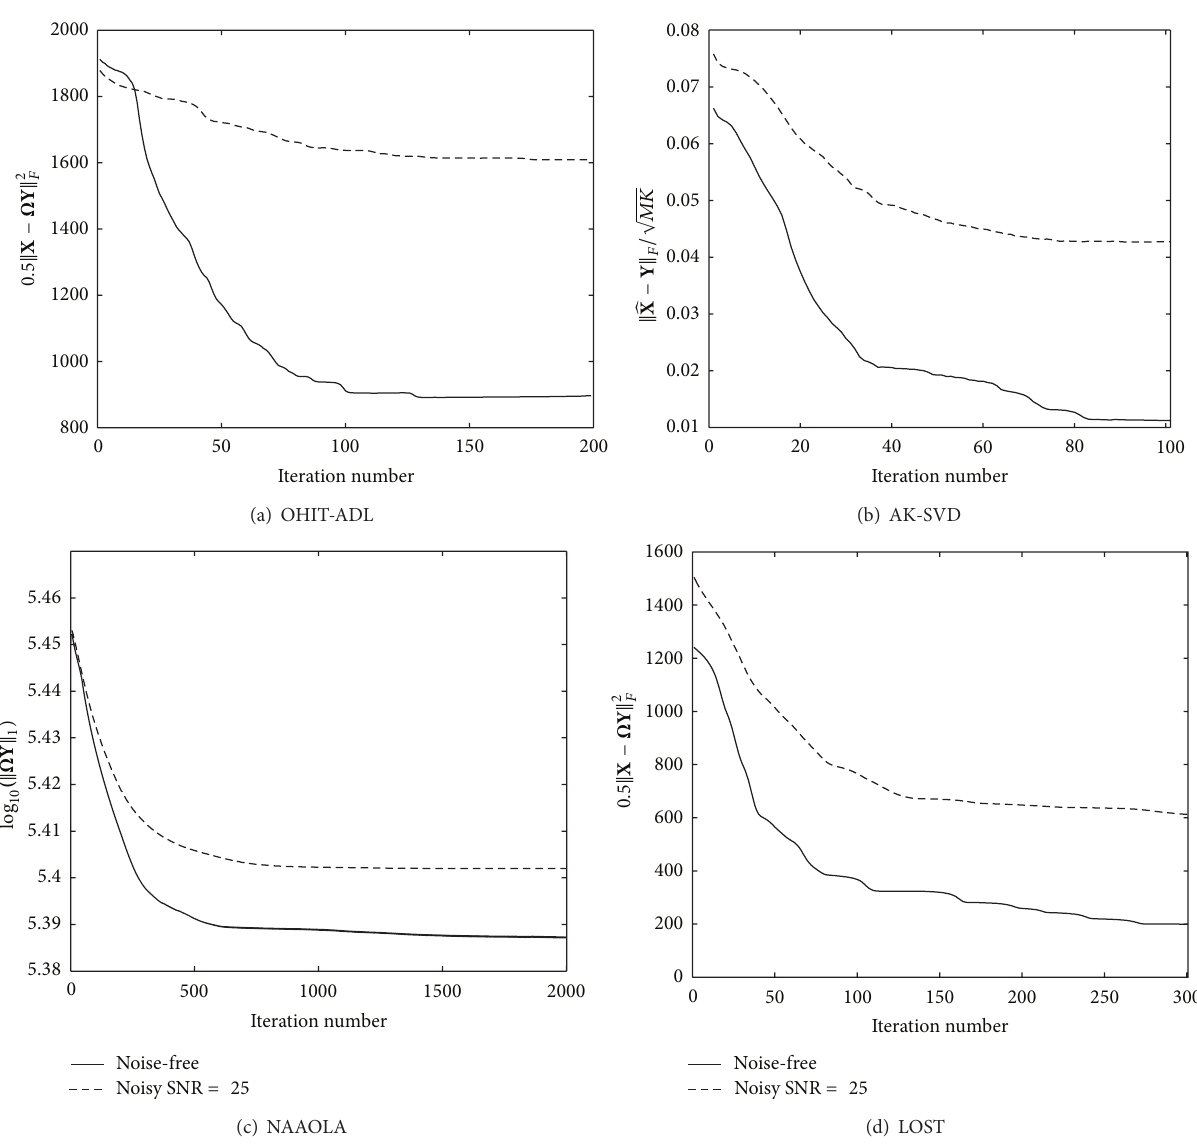
Input : Observed data Y ∈ 𝑅 𝑀×𝐾 , the initial dictionary Ω Output